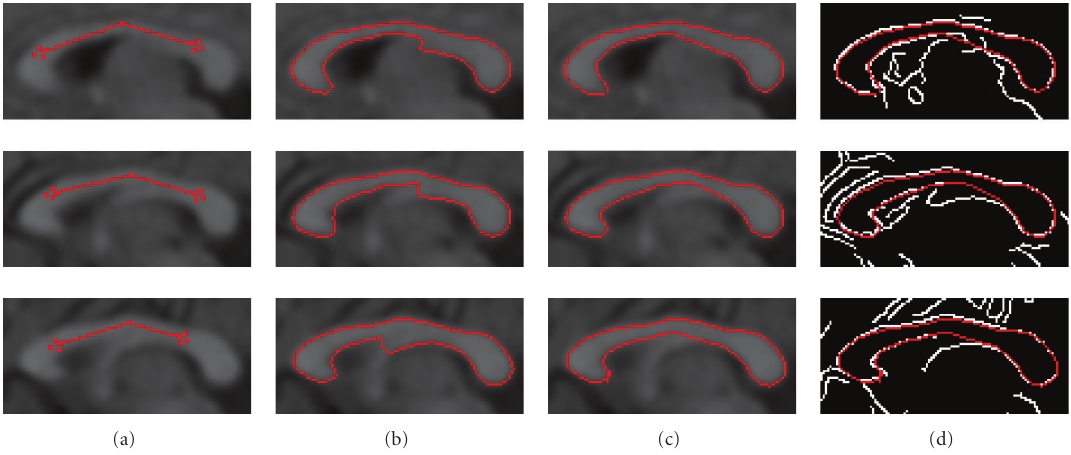
Figure 6: (a) The seed contour initialized by the user. (b) The fornix begins to appear without fornix removal. (c) The results with fornix removal. (d) The results overlaid on the edge